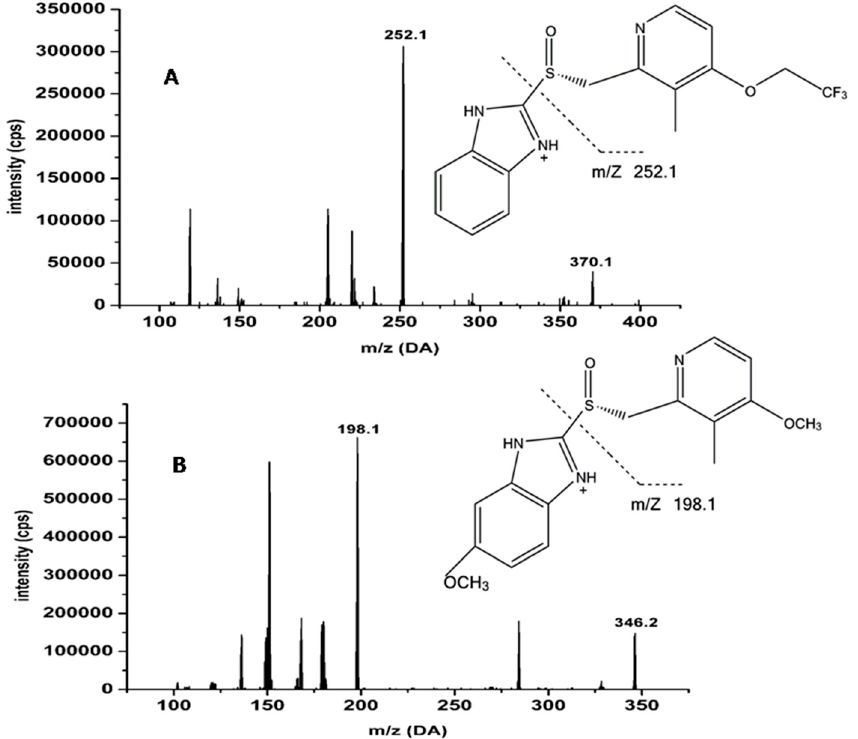
Figure 1. Chemical structures and full scan product ion of precursor ions of lansoprazole ( A ) and omeprazole ( B ; IS).